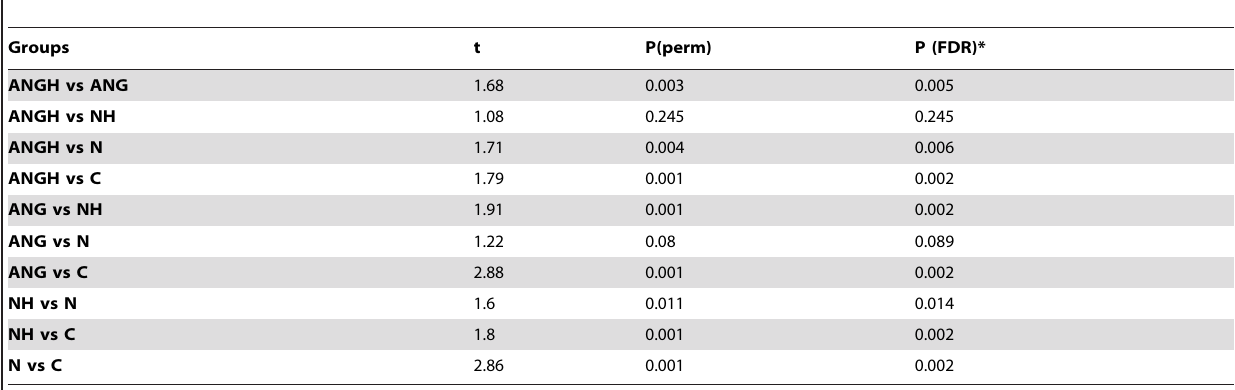
Table 2. Comparisons of microbial community composition between the five health status groups.